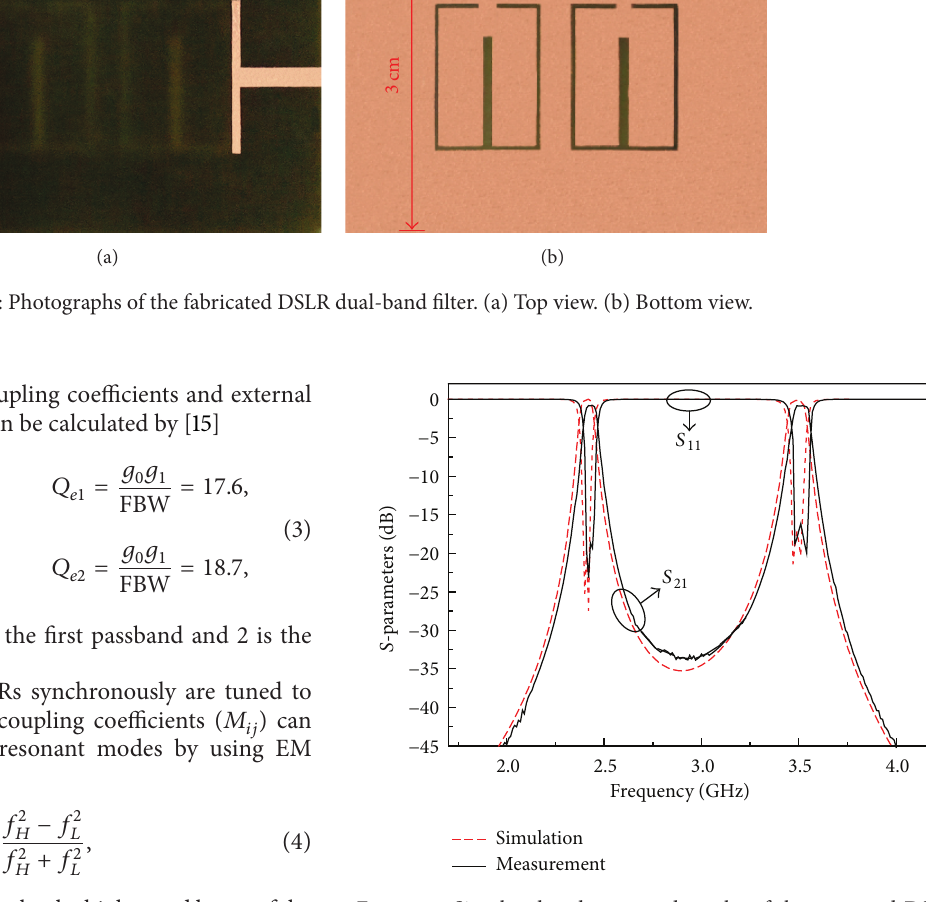
Figure 7: Simulated and measured results of the proposed DSLR dual-band